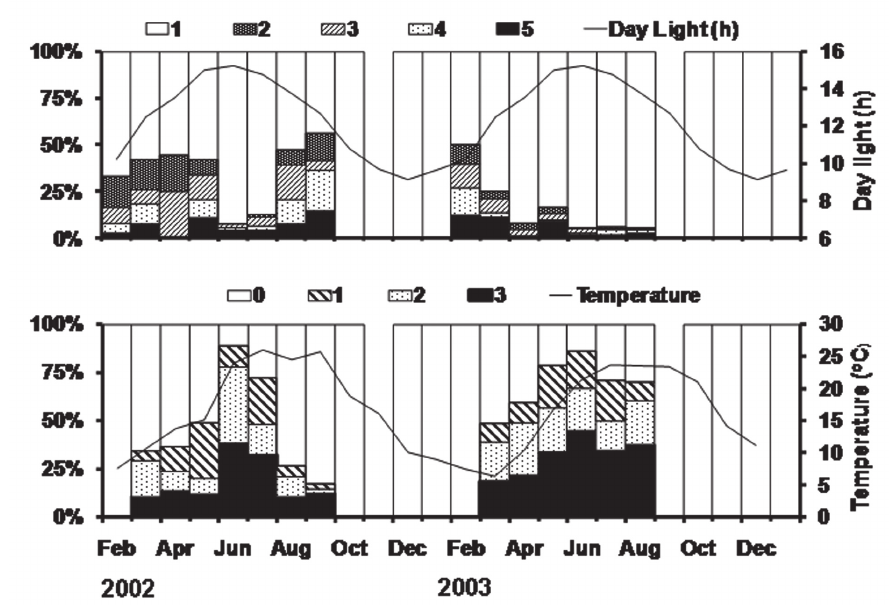
Fig . 5. – (a) monthly proportion of ovarian maturity stages in Palaemon elegans females and daylight hours. (b) monthly proportion of dif- ferent embryonic stages in ovigerous P . elegans females and water temperature ( o C).